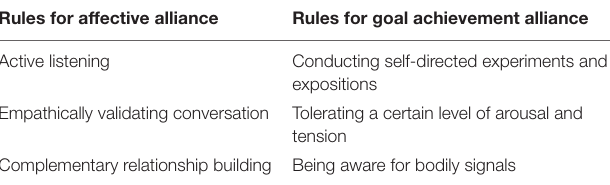
TABLE 1 | Examples of relationship rules and method